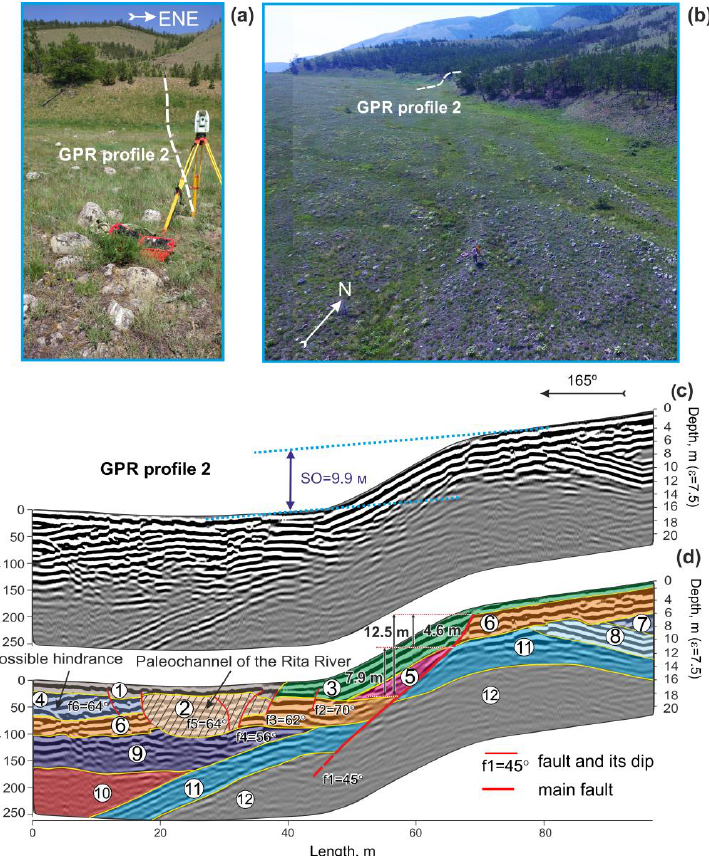
Figure 11. GPR profile 2 across the fault scarp (rupture 10, see location in Figures 4 and 5) cutting debris flow fan: ( a , b ) location of GPR line; ( c ) radargram; ( d ) its interpretation with inferred ruptures, vertical component of fault displacements (in meters), and radar facies marked by numbers in circles corresponding to layers of different dielectric properties. In contrast to the GPR profile 1, the observed cumulative displacement of 9.9 m is significantly less than the 12.5 m throw inferred for GPR profile 2. This is explained by